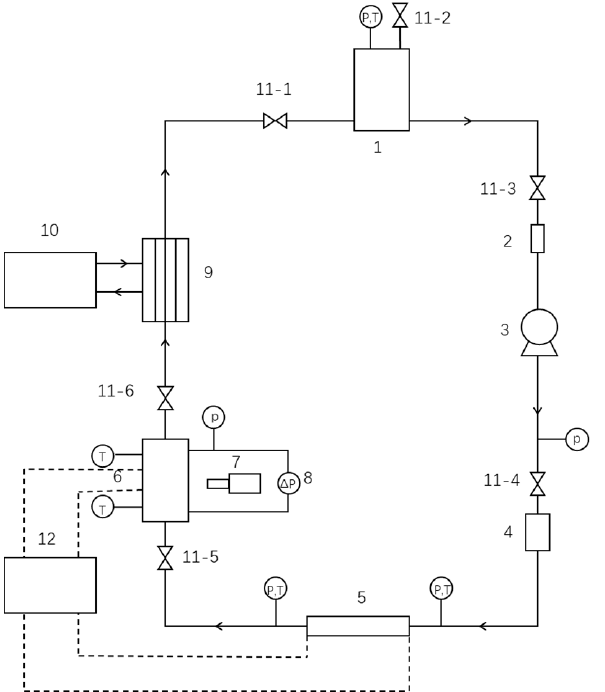
Table 1. The channel parameters.